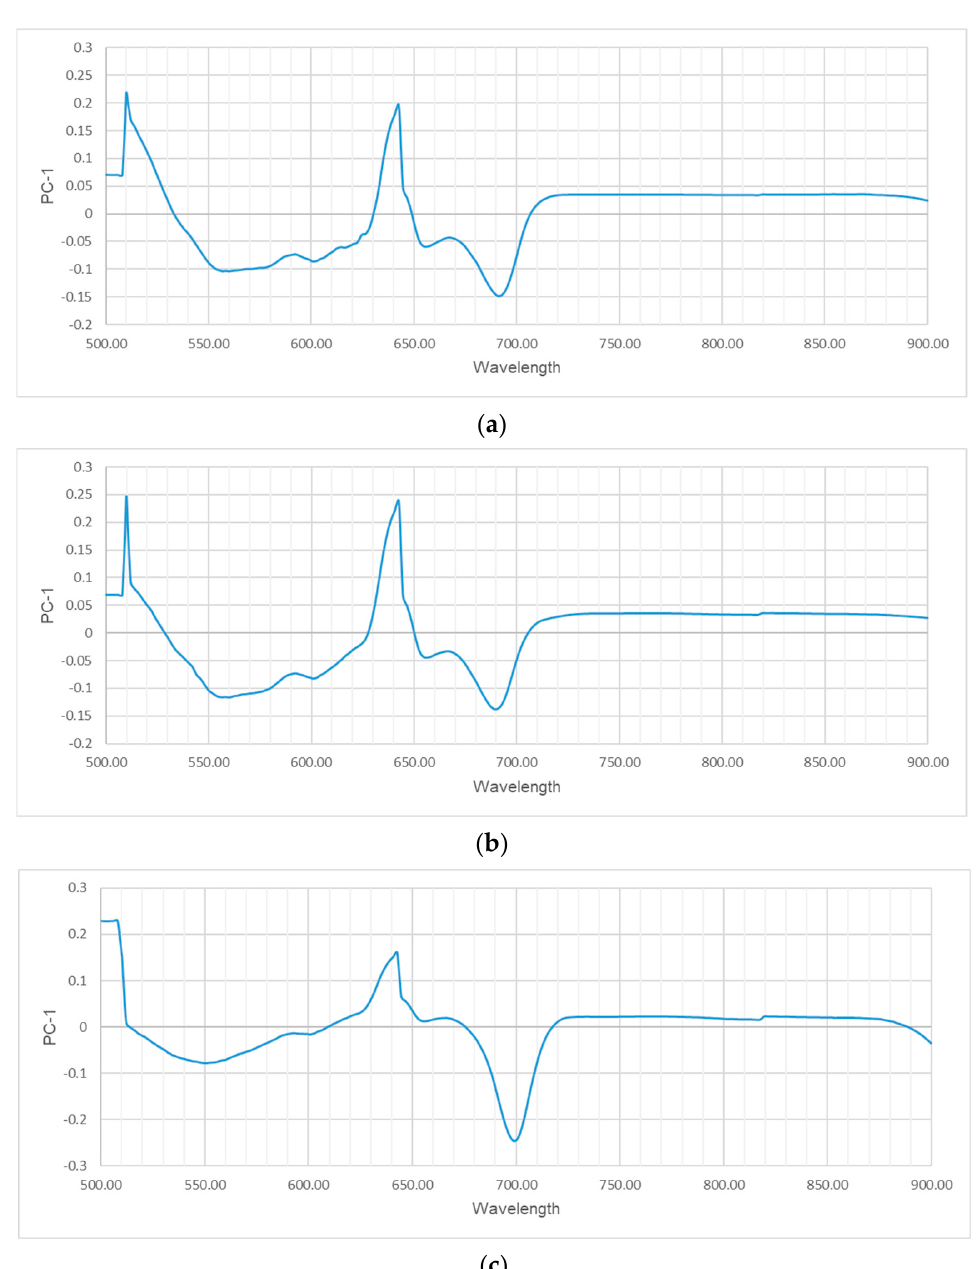
Figure 5. The factor loading plots for ( a ) high, ( b ) medium, and ( c ) low K levels.